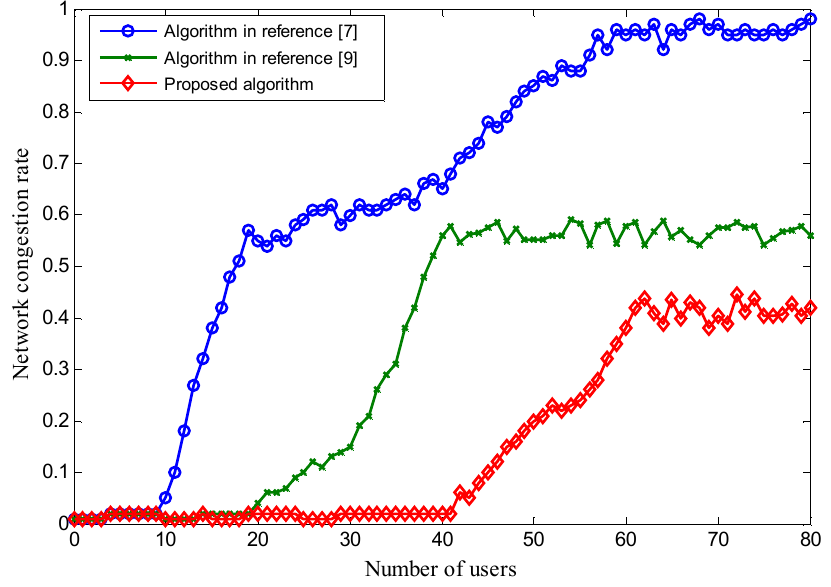
Figure 6. The integrated network congestion rate with smaller wireless network bandwidth.